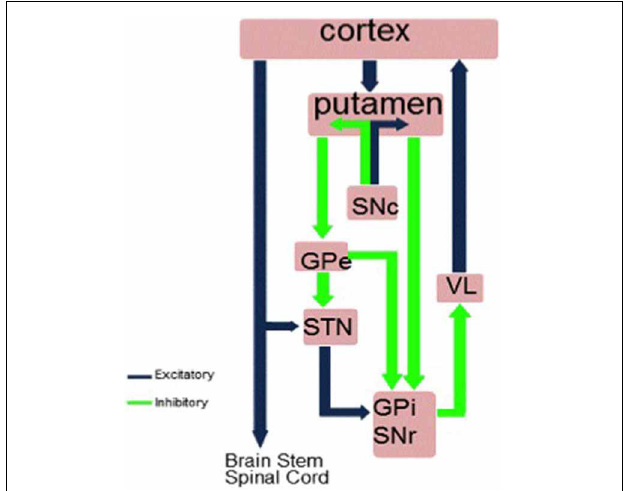
FIGURE 1 | The hyperdirect, direct and indirect pathways between the striatum and cortex. GPi, internal segment of globus pallidus; GPe, external segment of globus pallidus; STN, subthalamic nucleus; SNc, substantia nigra pars compacta; SNr, substantia nigra pars reticulate; VL, ventrolateral